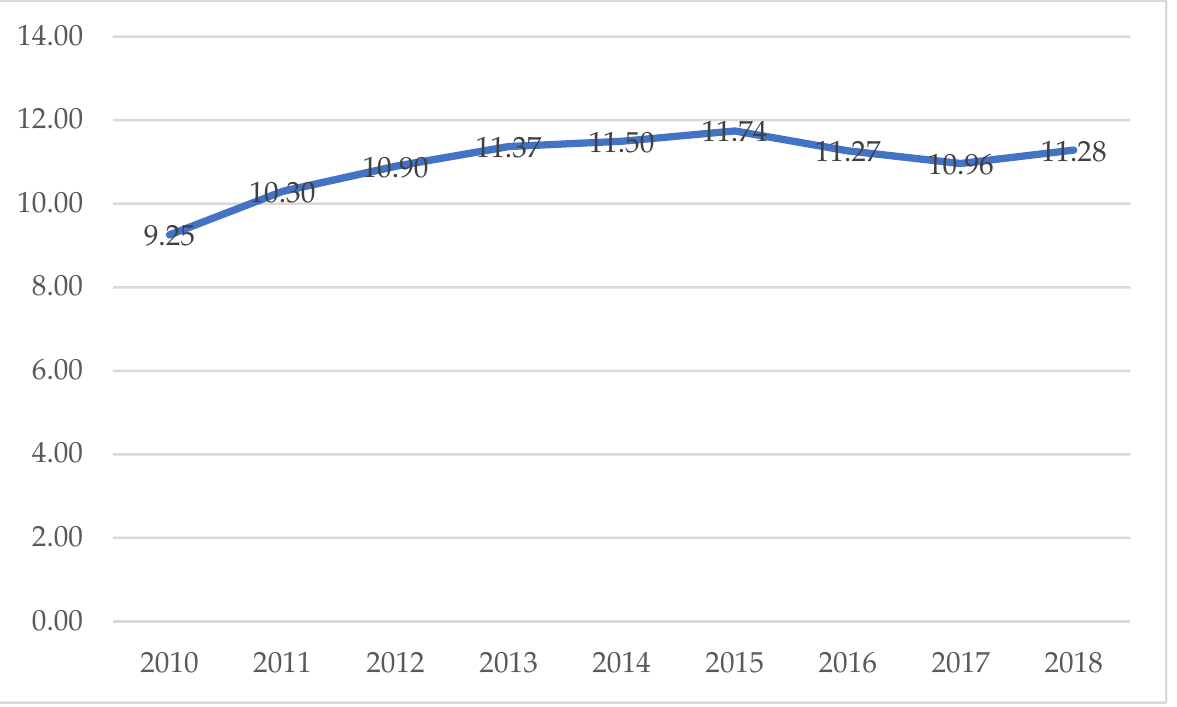
Figure 1. Share of energy from renewable sources [%]. Source: Eurostat.